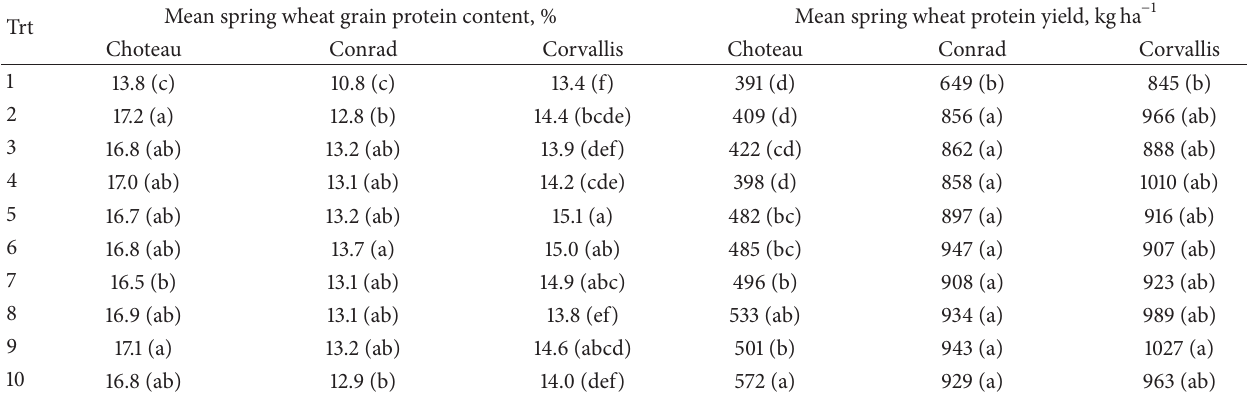
Table 5: Mean spring wheat grain protein content and protein yield, Choteau, Conrad, and Corvallis, 2012. Mean spring wheat grain protein content, Trt